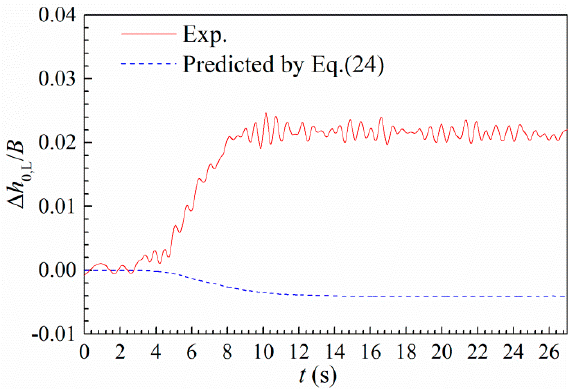
Figure 16. Time history of the coupled heaving drift during a post-critical LCO and the prediction by quasi-steady theory as Equation (24) (Case A1, U * = 5.365). Sensors 2020 , 20 , x FOR PEER REVIEW